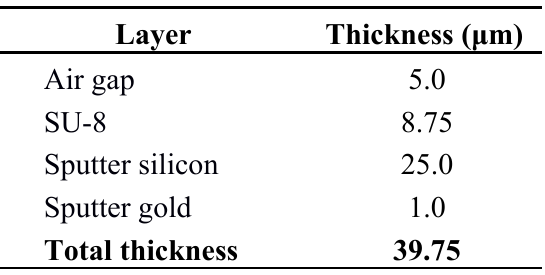
Table 2. Thickness of layers constituting the encapsulation